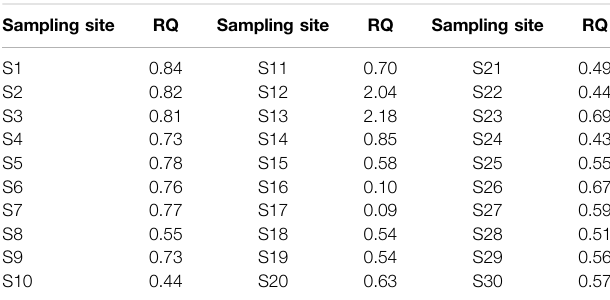
TABLE 3 | Risk quotients (RQs) of Hg at the 30 sampling points of Taihu Lake. Sampling site